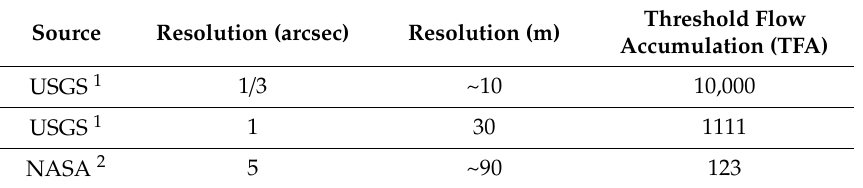
Table 1. Digital elevation models (DEMs) with their respective data sources, spatial resolutions in arcsec and meters, and threshold flow accumulation